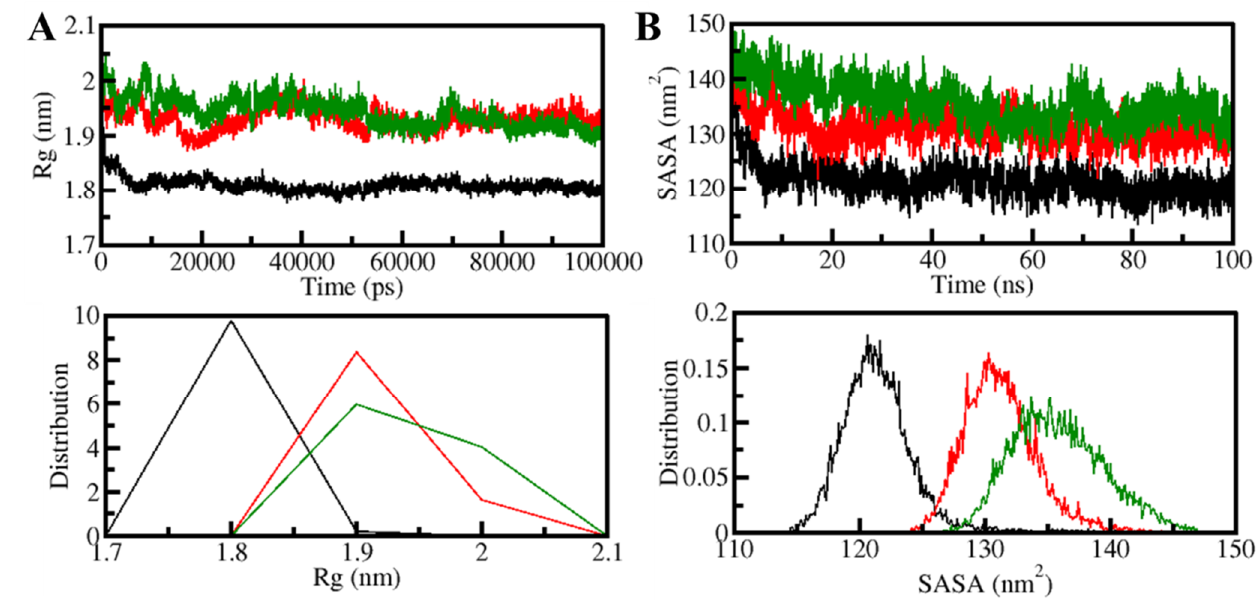
Figure 4. The structural compactness of PDPK1 upon 11-Hydroxytephrosin and Torosaflavone A binding. ( A ) The R g and ( B ) SASA plot of PDPK1 with 11-Hydroxytephrosin and Torosaflavone A binding.